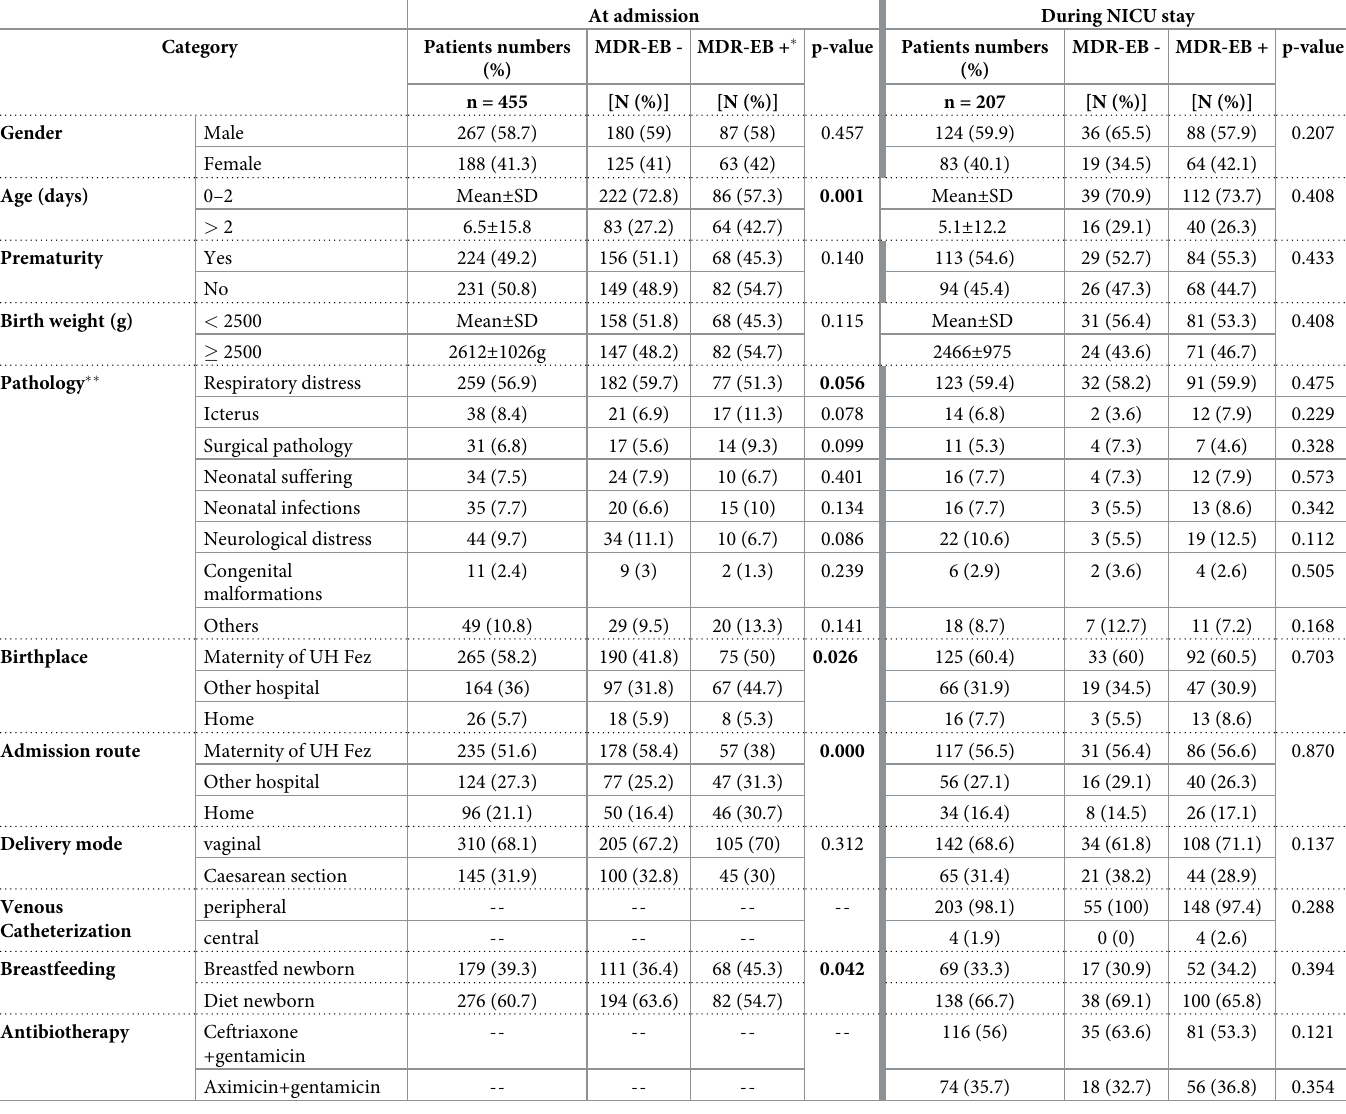
Table 2. Association between patient’s characteristics and prevalence of multidrug-resistant Enterobacteriaceae carriage on the day of admission and during hospi- talization at